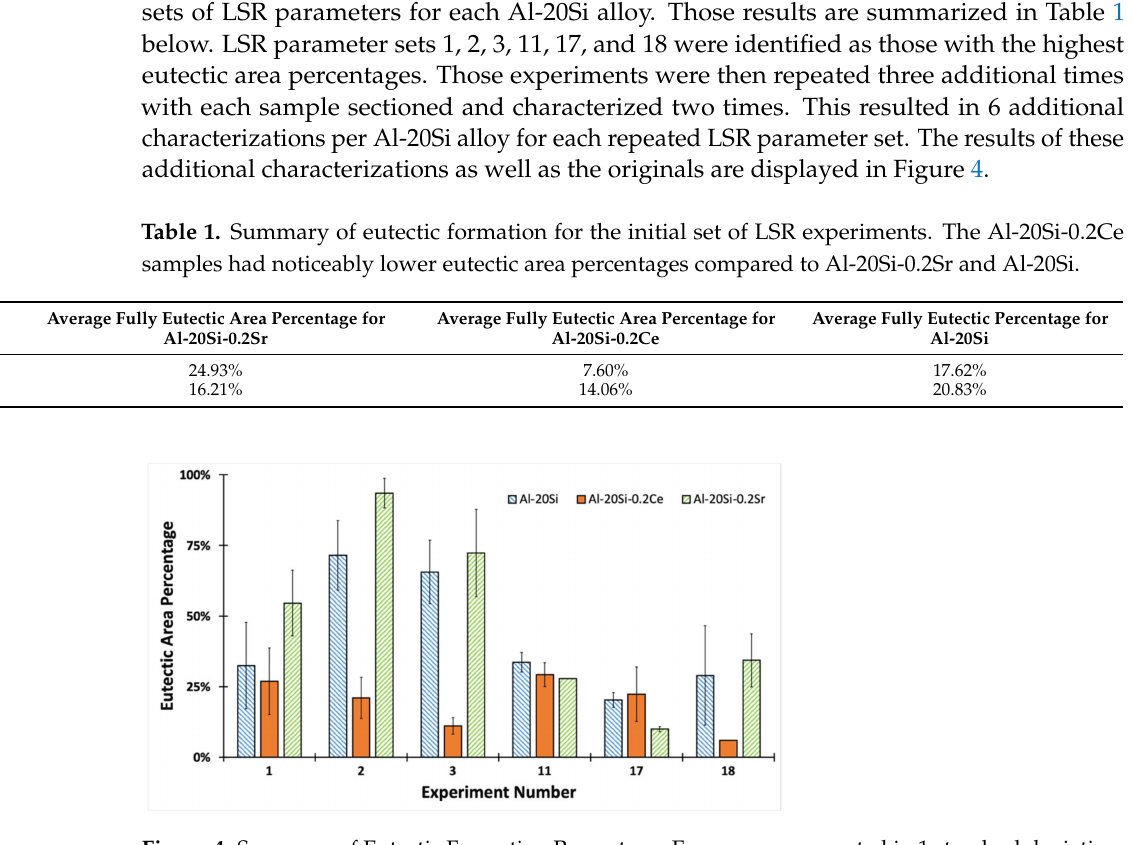
Figure 4. Summary of Eutectic Formation Percentage. Errors are represented in 1 standard deviation.